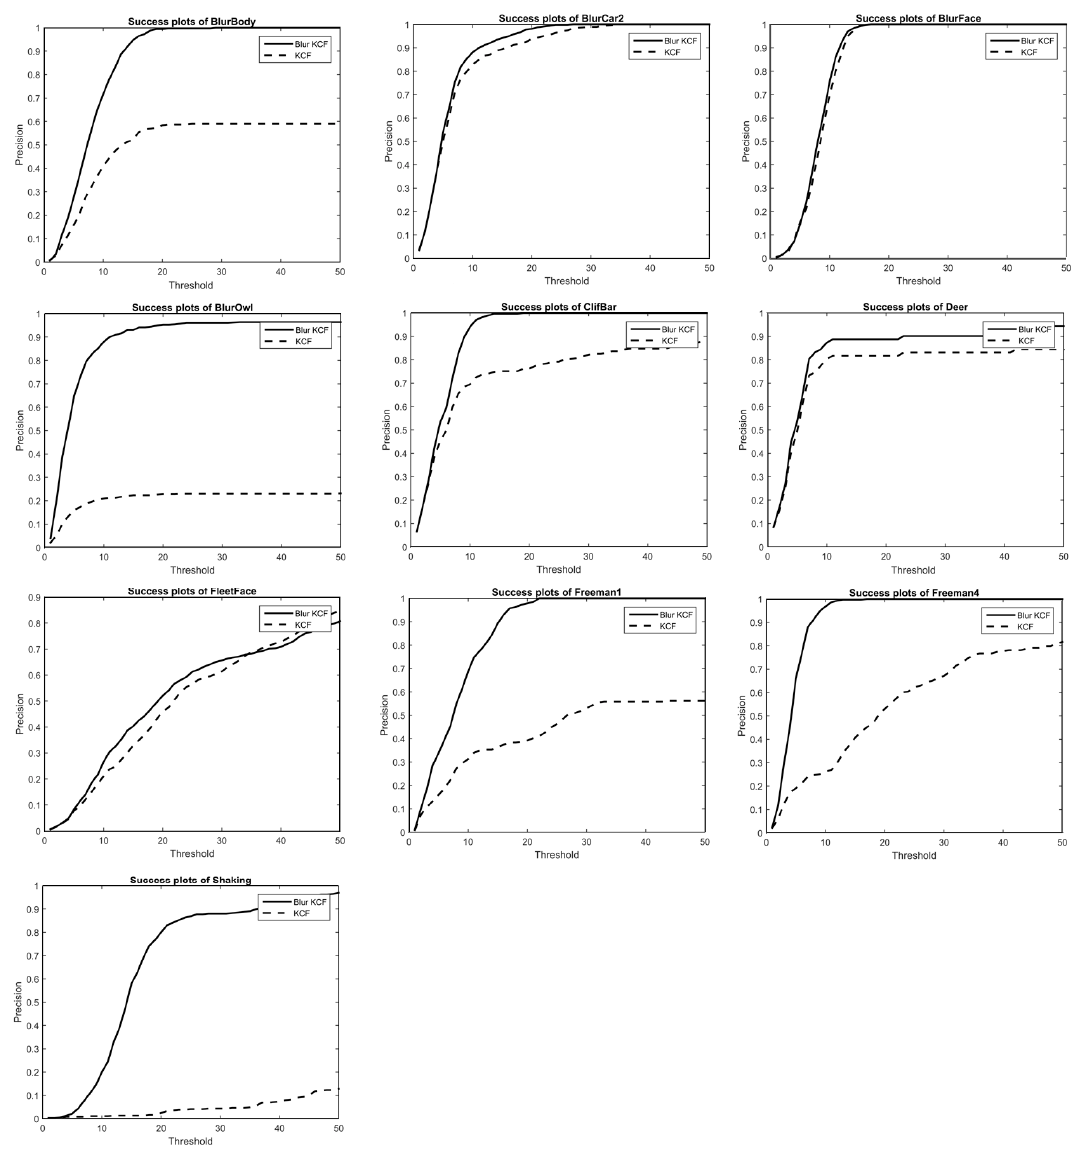
Figure 4. Precision plot in comparison with KCF.